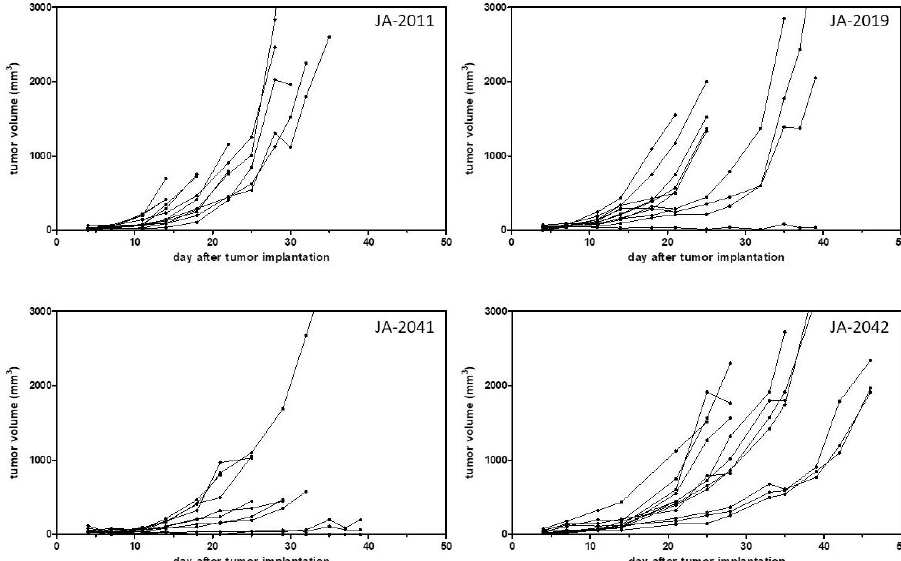
Figure 3. Take rates and growth curves of four cMDI models. Growth curves of 10 – 12 mice each implanted with frozen tumor pieces are shown. Tumor growth was measured twice weekly by